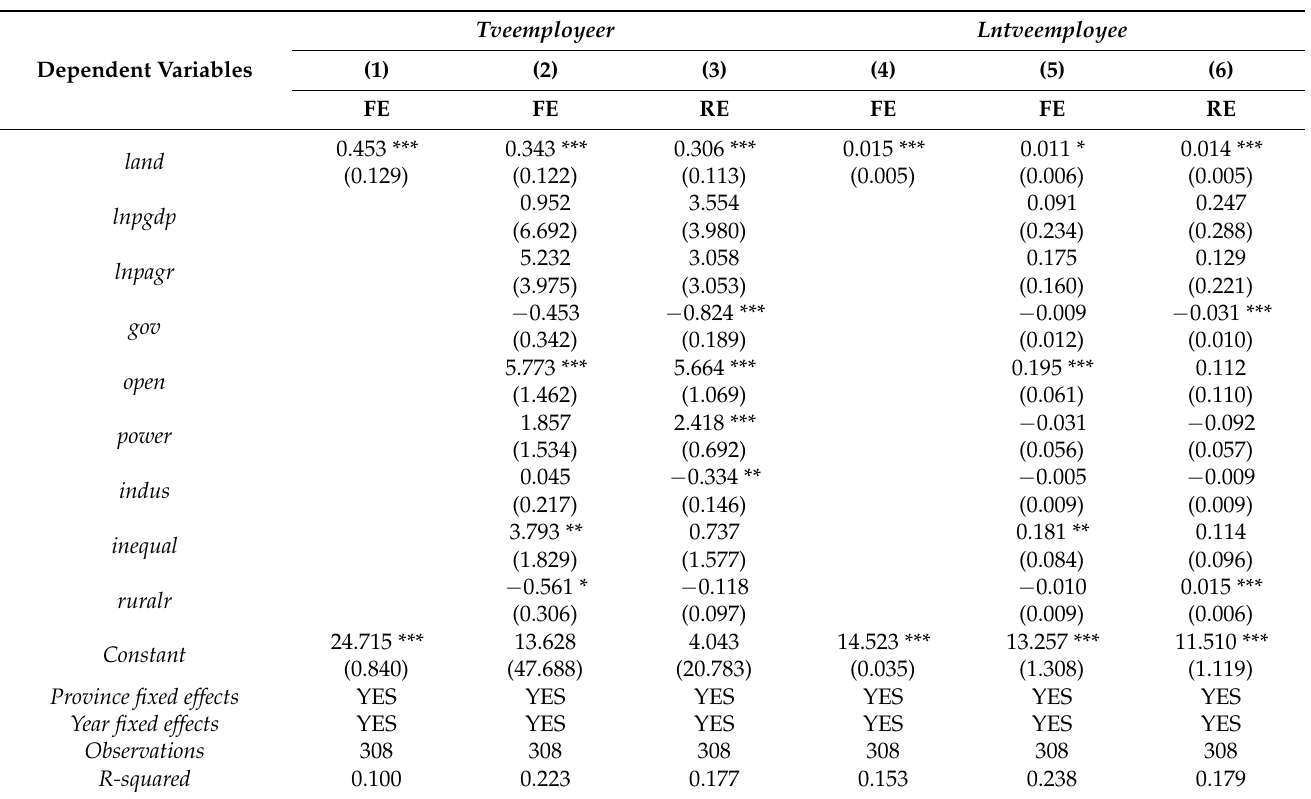
Table 2. The transfer of rural collective construction land and the rise of TVEs (1987–1997): benchmark